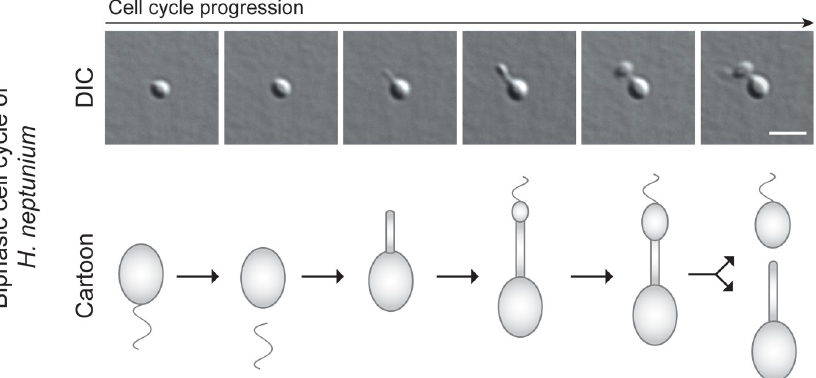
Fig 2. Biphasic life cycle of H . neptunium . Shown are a timelapse series (DIC) and a cartoon of a single H . neptunium cell that progresses through its cell cycle. The swarmer cell sheds its flagellum and differentiates into a stalked cell, which then produces a bud at the end of its stalk, thereby ultimately giving rise to a new swarmer cell. The stalked mother cell elongates its stalk and then immediately starts the next division cycle, whereas the swarmer cell first needs to differentiate into a stalked cell to proliferate. Scale bar: 3 μ